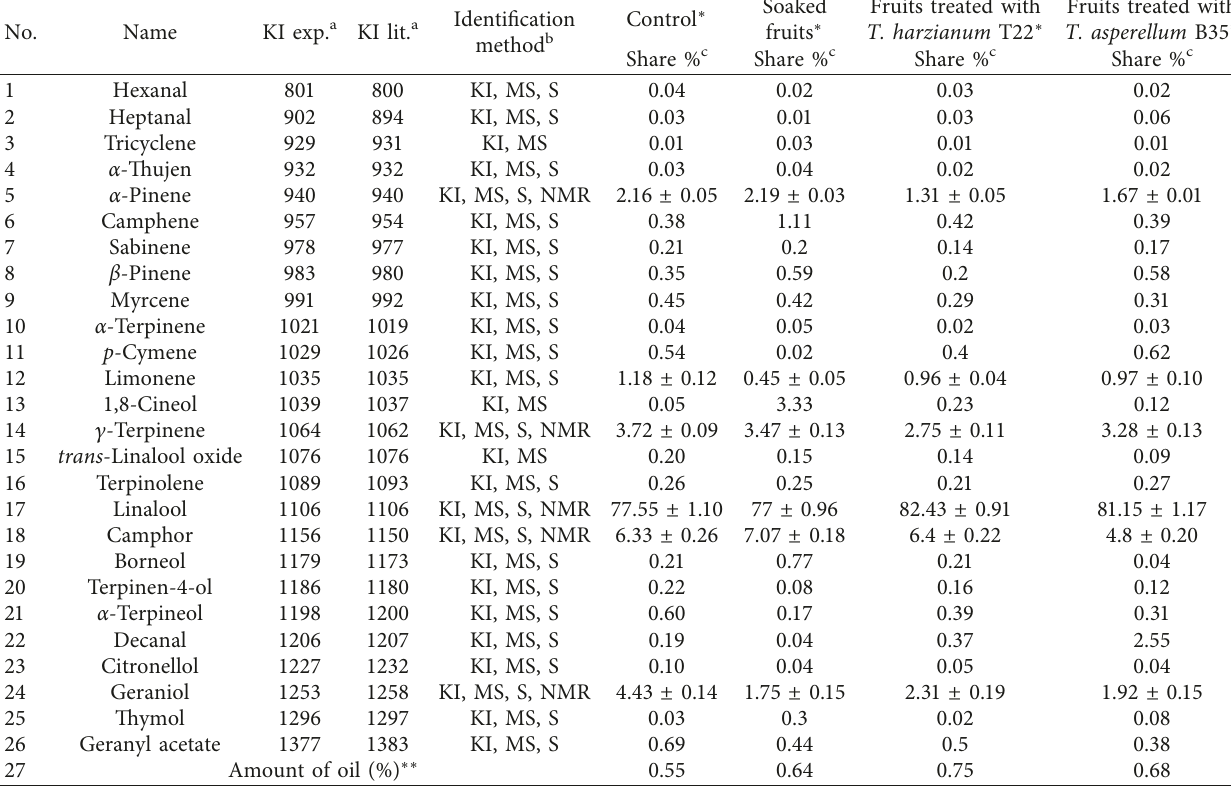
Table 4: Quality and quantity composition of coriander oil and its